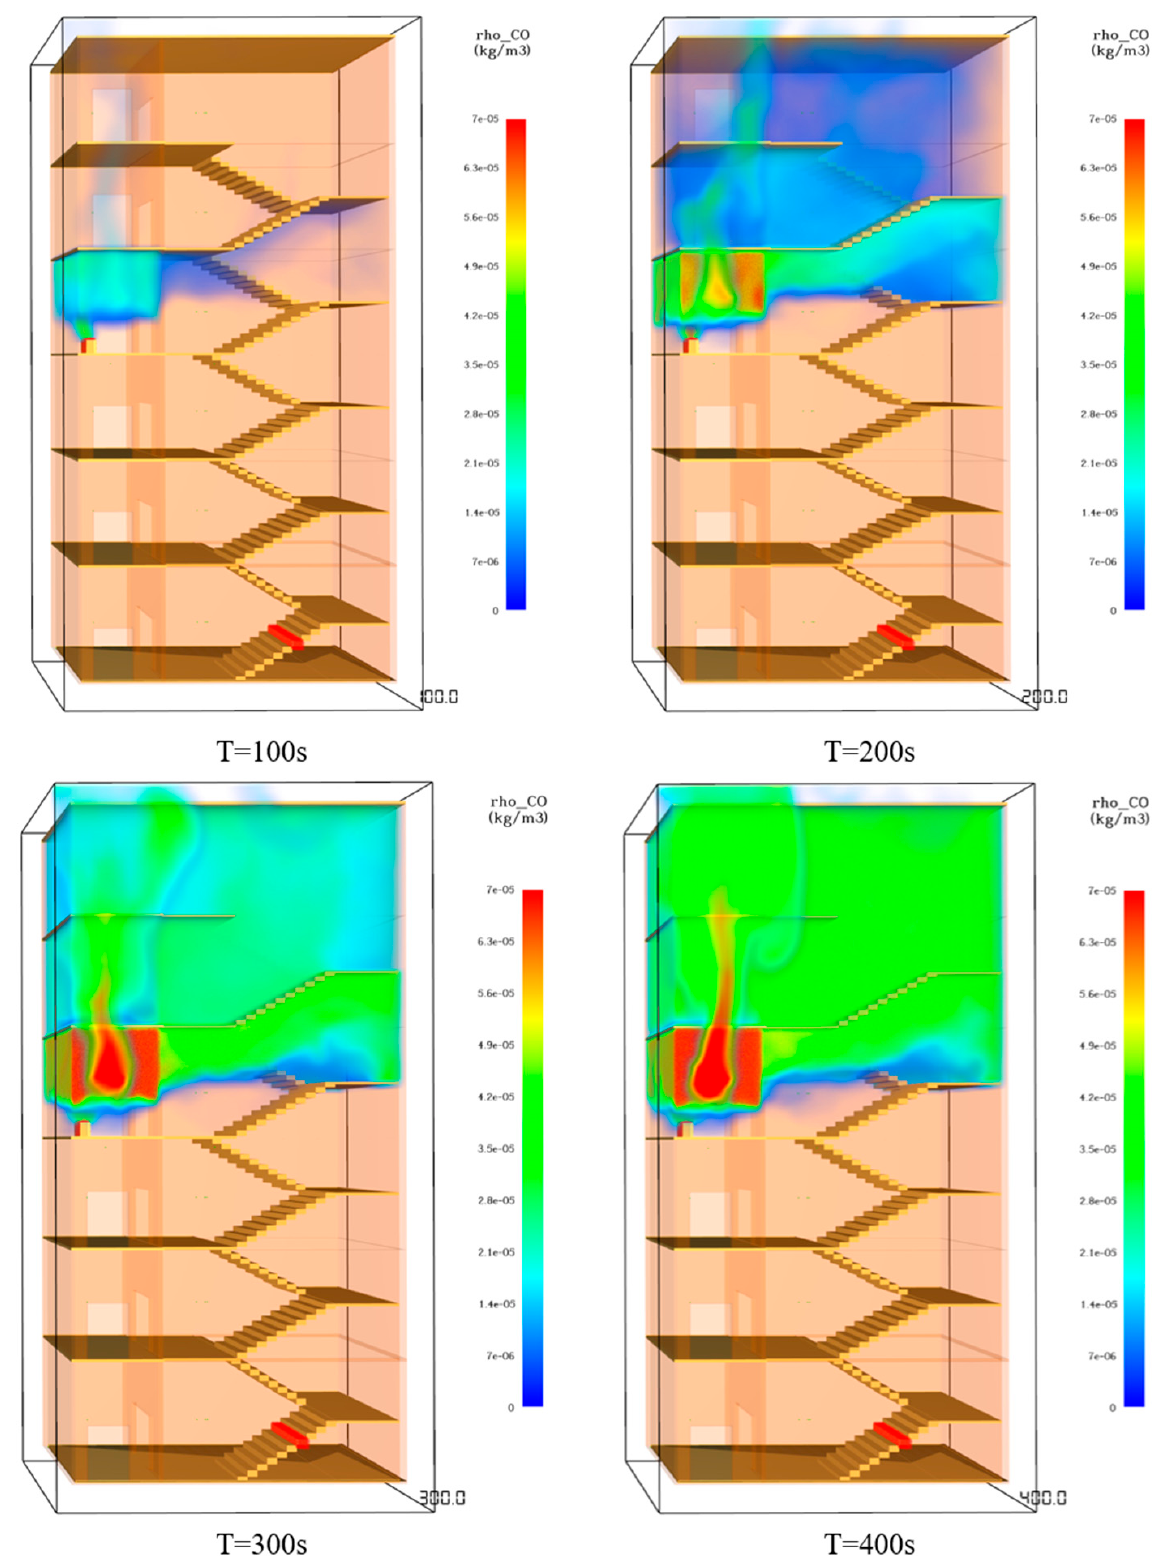
Figure 10. CO gas concentration in the staircase front room and staircase.